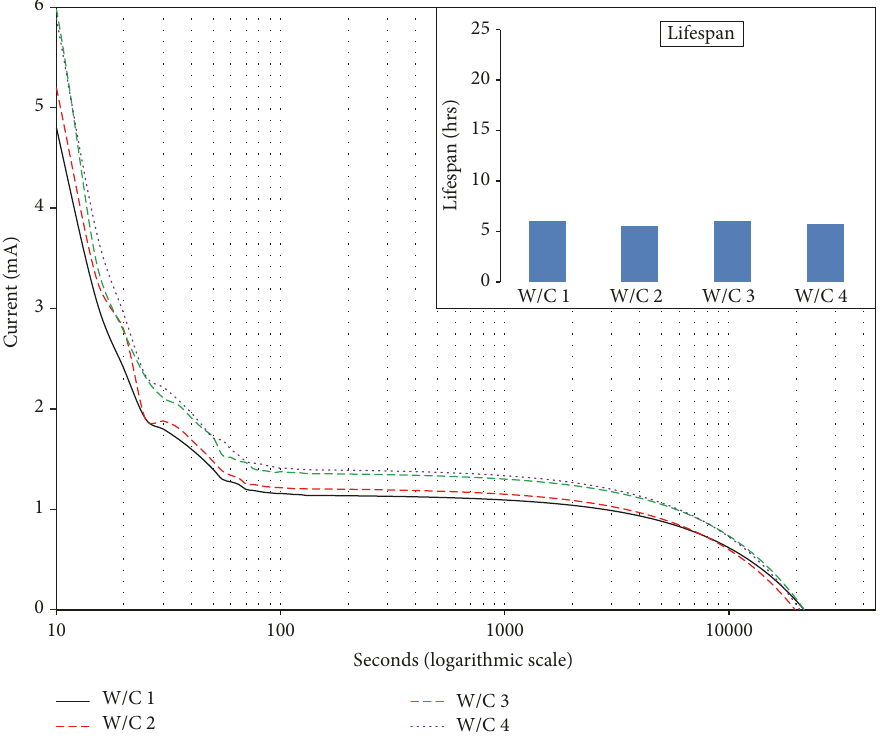
Figure 7: Current discharge curves across a 10 Ω resistor for increasing w/c ratio.